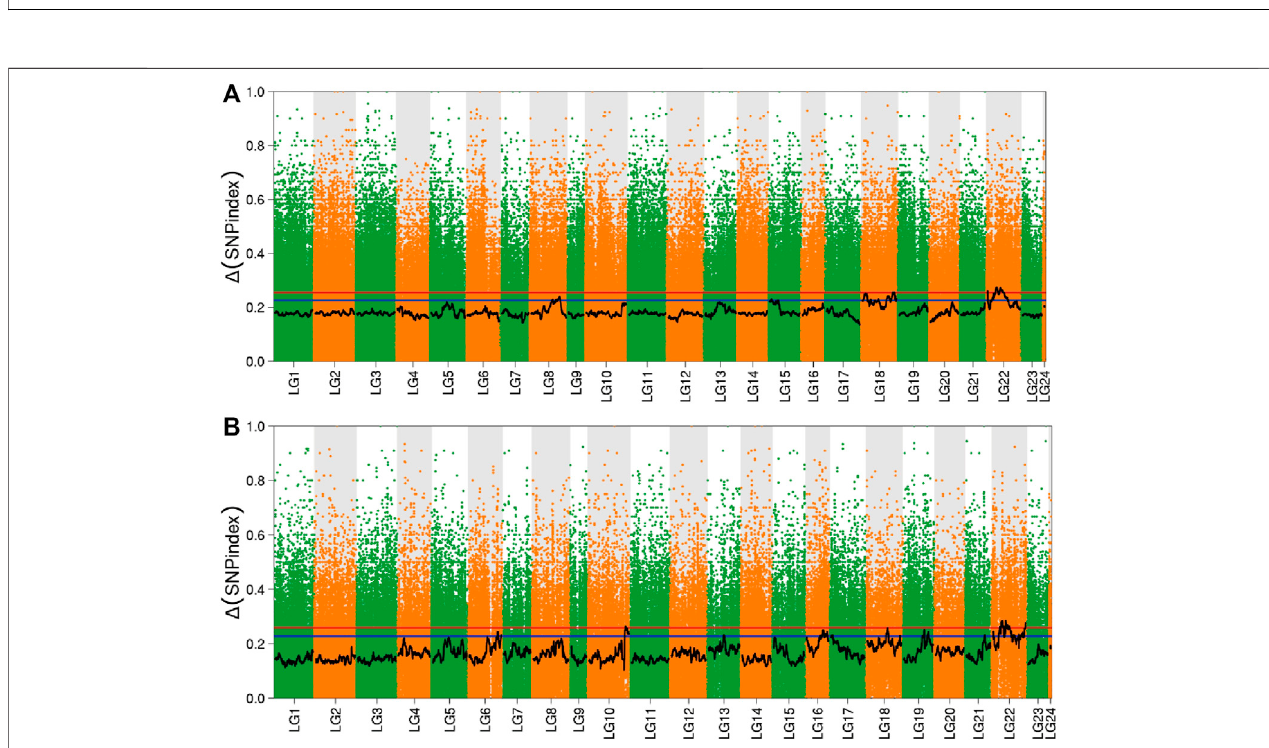
FIGURE3| Distributionof Δ (SNP-index)inthebrainandliver.Note: (A) Brain; (B) Liver;Theredlineinthe fi gureisthe99%con fi dencelevelline,andthebluelineis the 95% con fi dence level line.